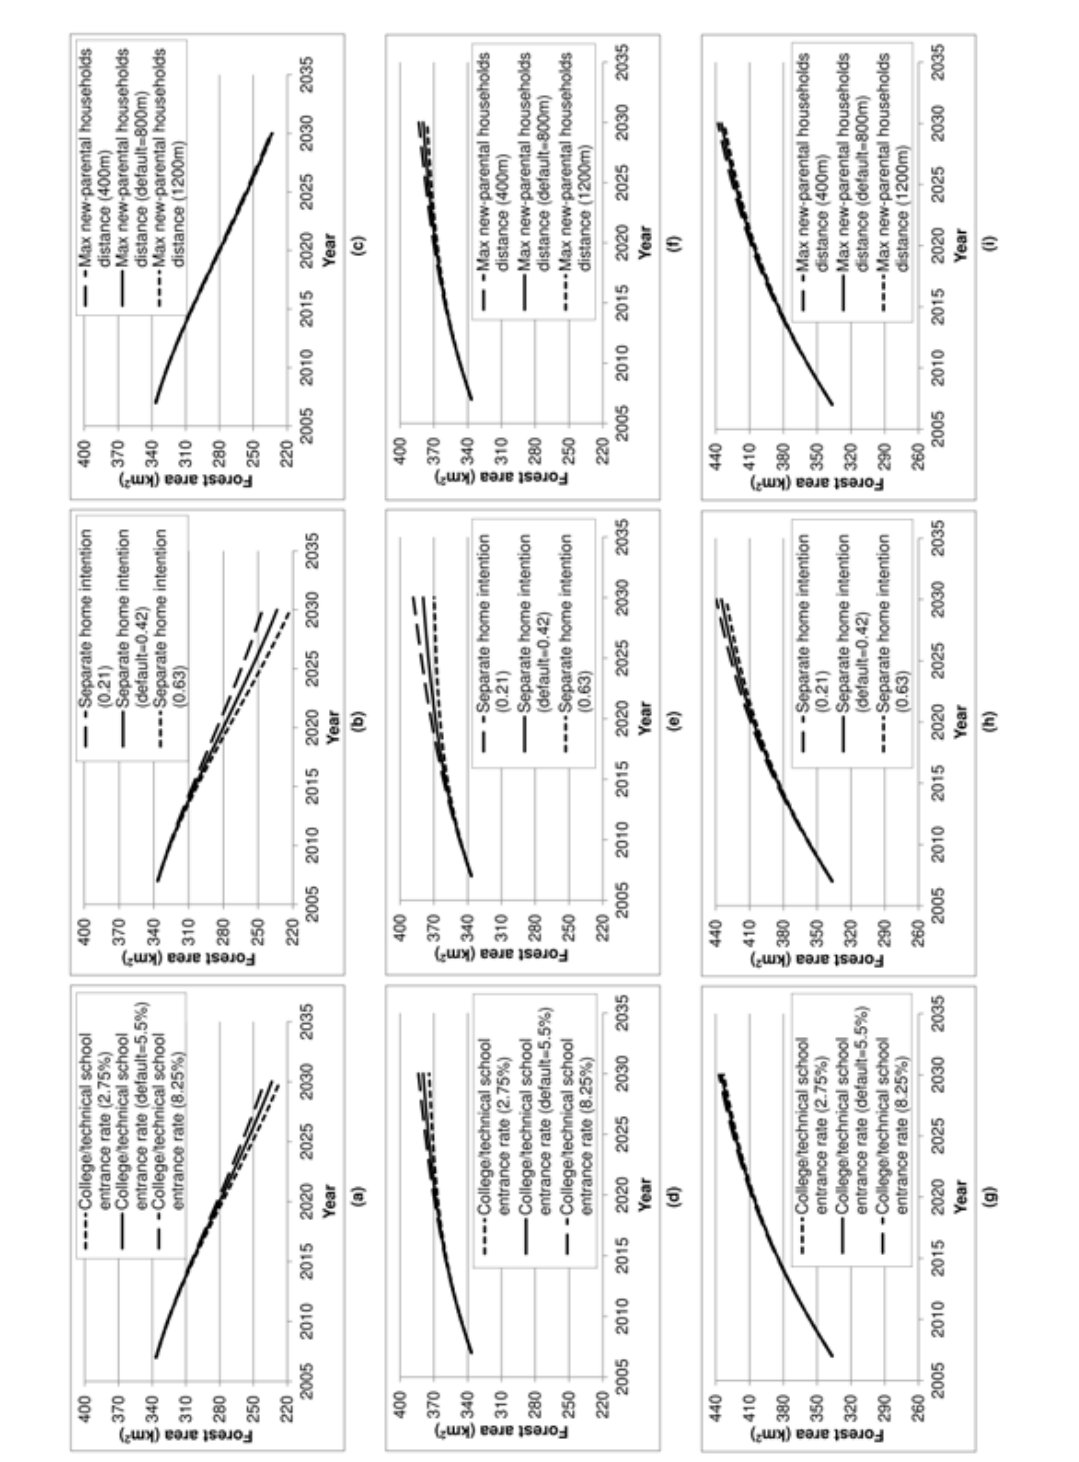
Fig. 6 . Effects of socio-demographic factors on forests under no payment (a, b, c), cash payment (d, e, f), and electricity payment (g, h, i)